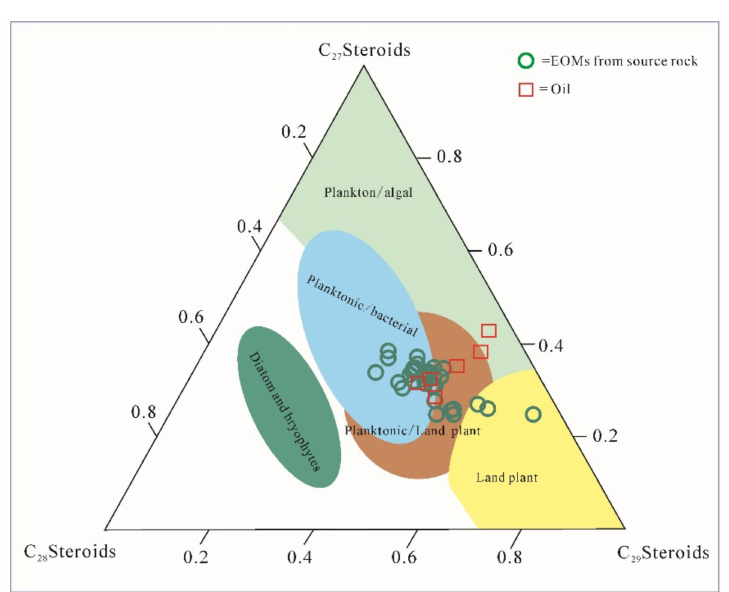
Figure 11. Ternary diagram of the relative proportions of steroids C27, C28 and C29 (the relationship between the organic matter input and the depositional environment